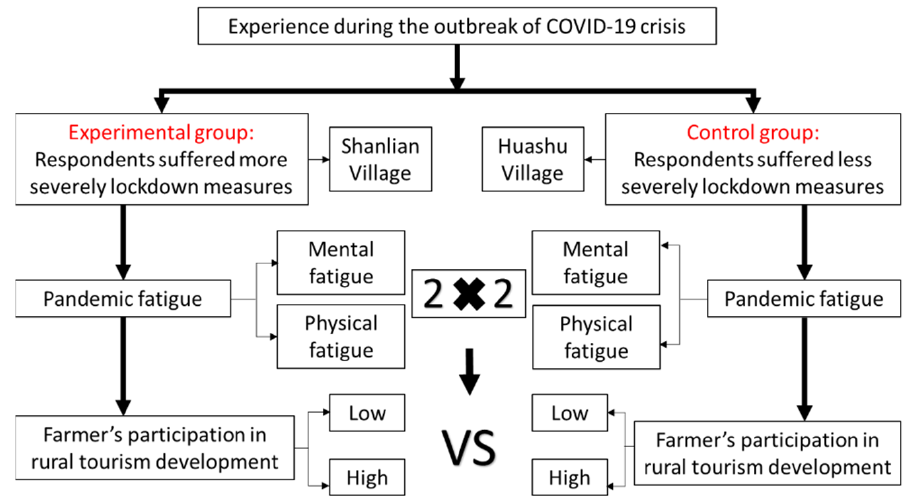
Figure 3. Flowchart of the experimental design. Table 2 provides an overview of the sample of the 897 respondents concerning gender, age, and educational background in each scenario (survey condition). Of the 526 farmers who engaged in rural tourism business in Shanlian Village, 54.94% were female. The average age of the participants was 38.42 years (standard deviation (SD) = 8.48), ranging from 20 to 70 years. The majority of the participants had a secondary school or higher education (67.30%). Of the group involved in Huashu village’s rural tourism, 56.33% were female. The average age of participants was 36.21 years (SD = 6.52). Most of them